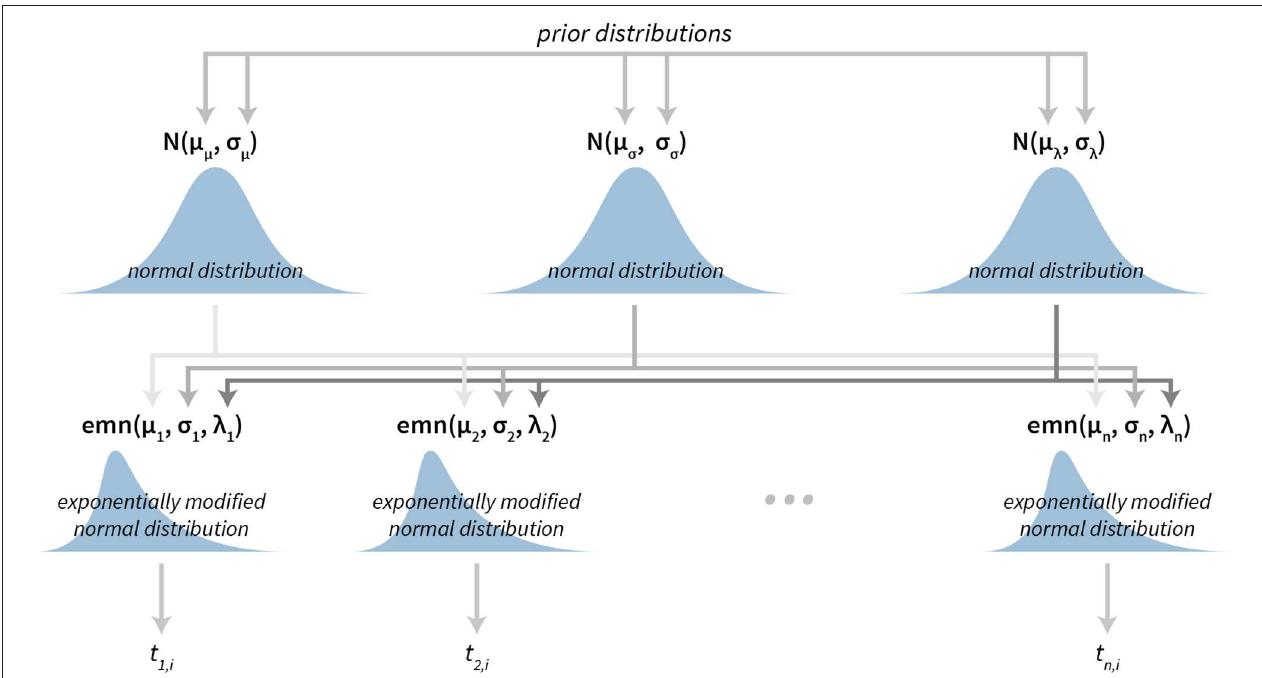
FIGURE 2 | The visualization of the Bayesian reaction time model. The model has a hierarchical structure. Reaction times belonging to each individual subject ( t n , i depicts i -th reaction time of the subject n ) are used to construct exponentially modified normal distributions at the subject level. Parameters of subject level distributions are then connected at the group level by using normal distributions, which can then be used for group level